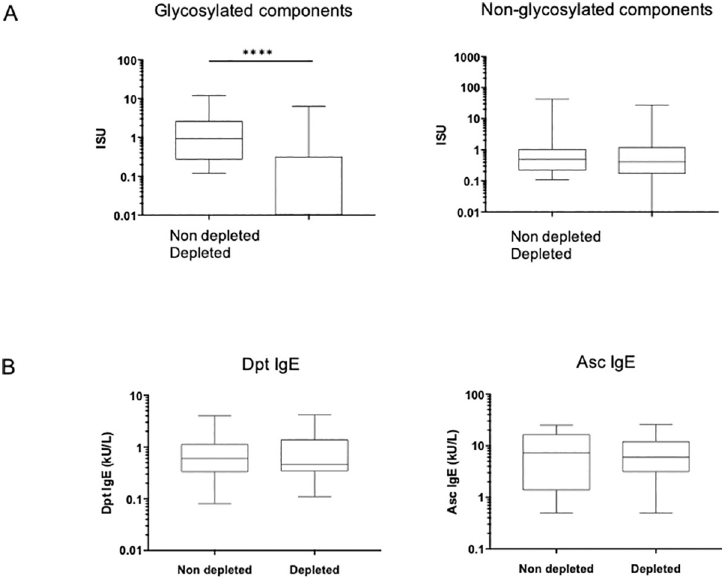
Fig 4. Effect of Phlp4 IgE depletion on the levels of IgE. A. Specific IgE against components before (Non-depleted) and after depletion (Depleted) with Phl p4 as measured by ISAC for glycosylated (Phl p 4, Cyn d 1, Cry j 1, Cup a 1 > MUXF3 and Pla a 1) allergens and non-glycosylated allergens (107 other components present on the ISAC microchip). B. Specific IgE against D . pteronyssinus (Dpt) and Ascaris (Asc) using ImmunoCAP before and after depletion with Phl p 4. ��� p < 0,001, before vs. after depletion, paired Wilcoxon test.